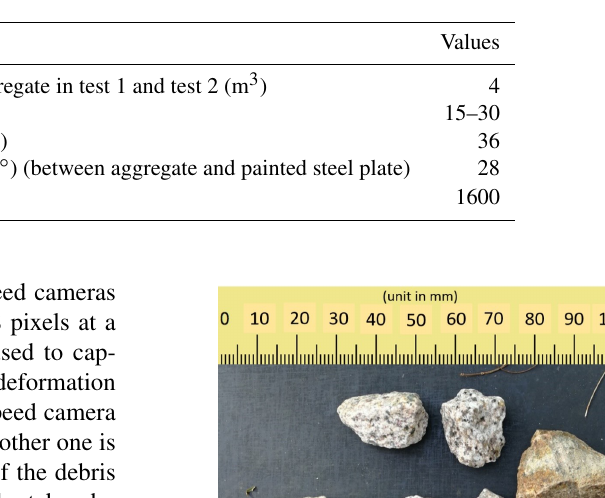
Table 1. Main properties of aggregate used in the test.